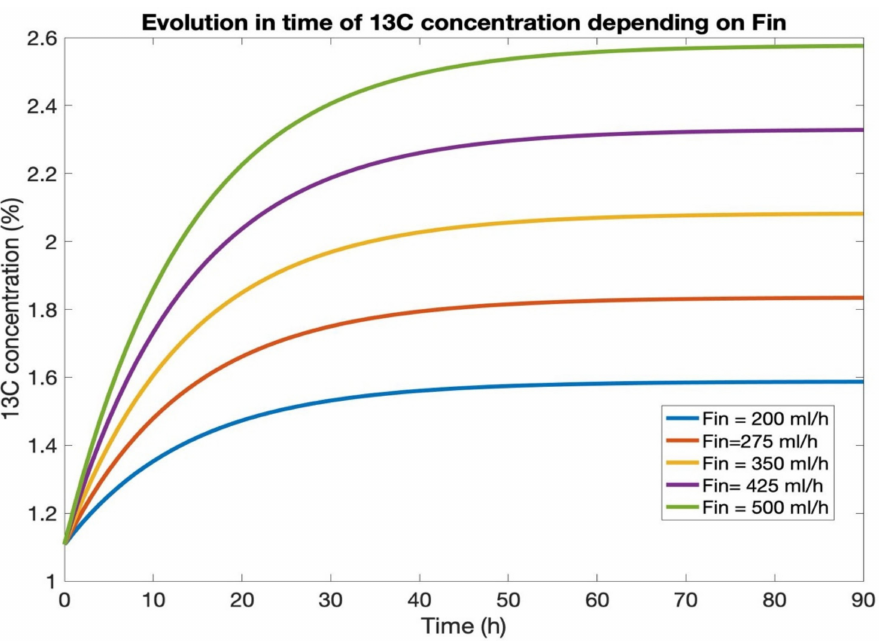
Figure 4. The comparative graph between the simulated responses of the process when the variation of the input signal occurs.